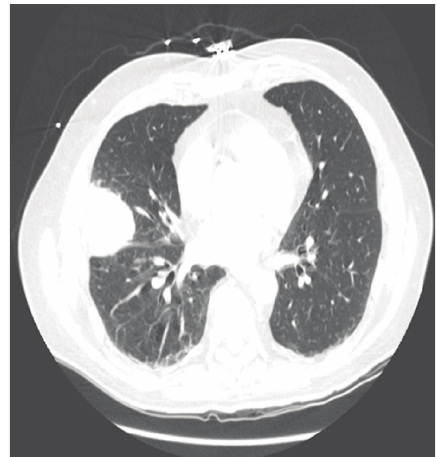
Figure 2: Chest CT scan demonstrating a large, rounded mass in the periphery of the right middle lobe.